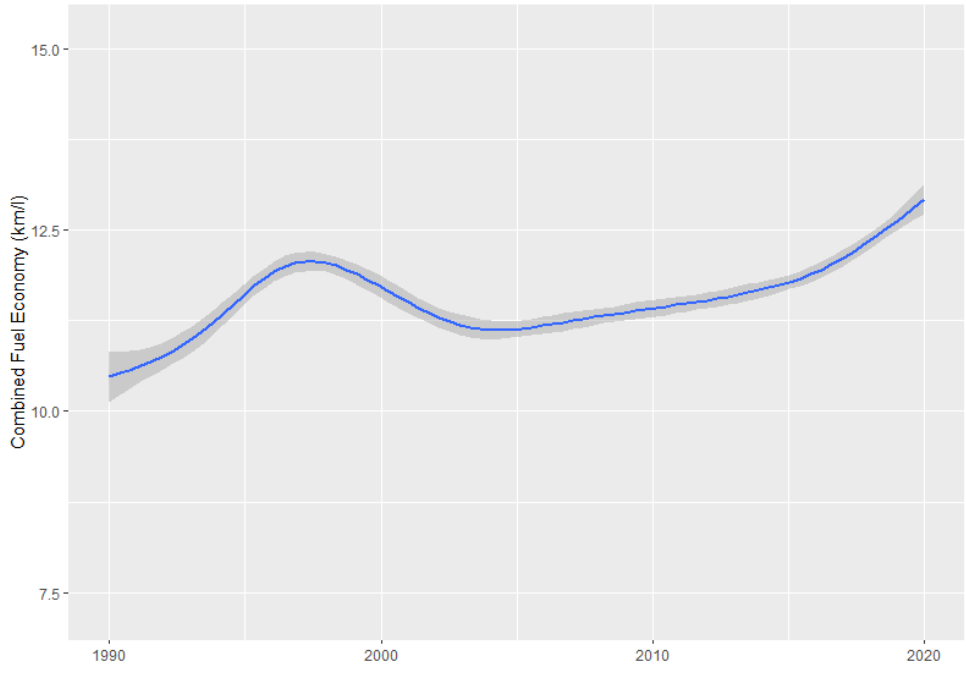
Figure 2. Combined FE in Brazilian transportation sector from 1990 to 2020 (horizontal